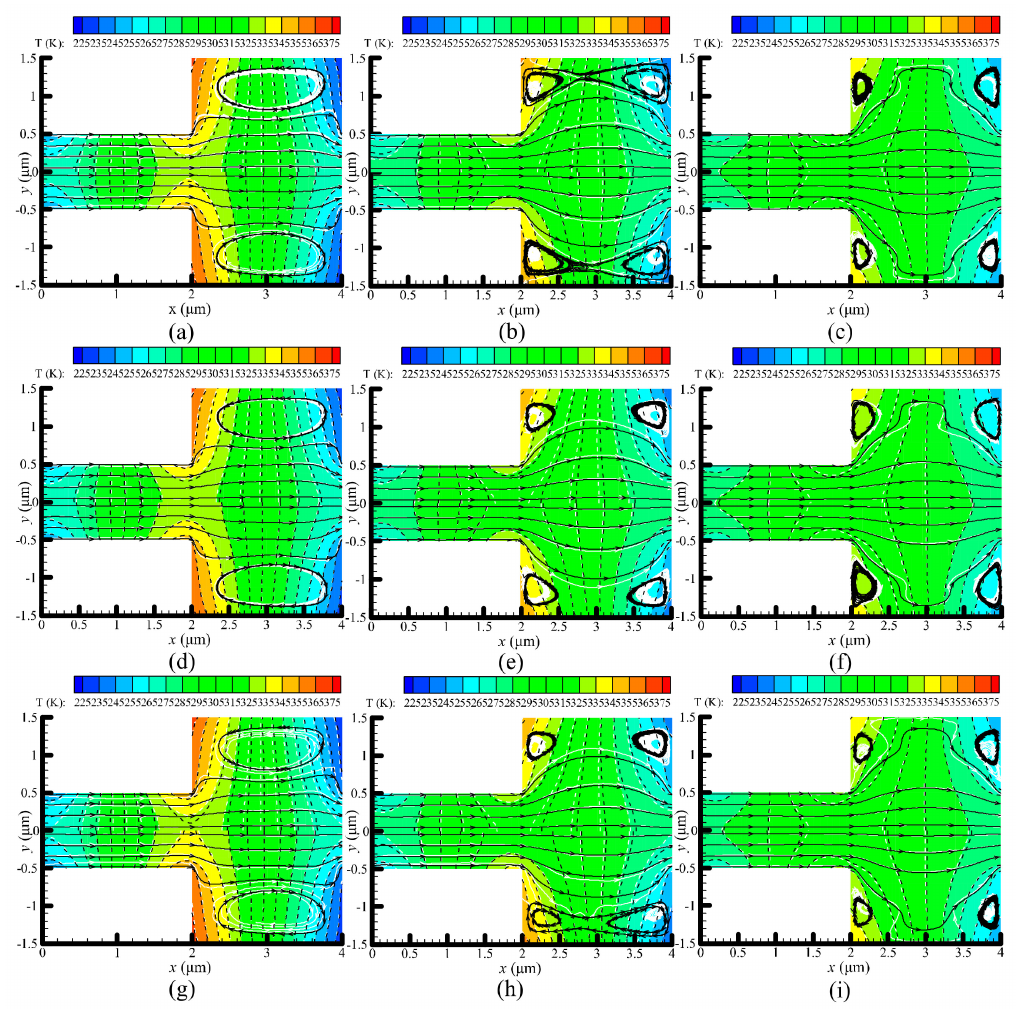
Figure 5. Temperature contours and velocity streamlines for di ff erent pressures and gas mixtures (N 2 :H 2 ). Dotted black lines: N 2 , while dotted white lines with colored background: H 2